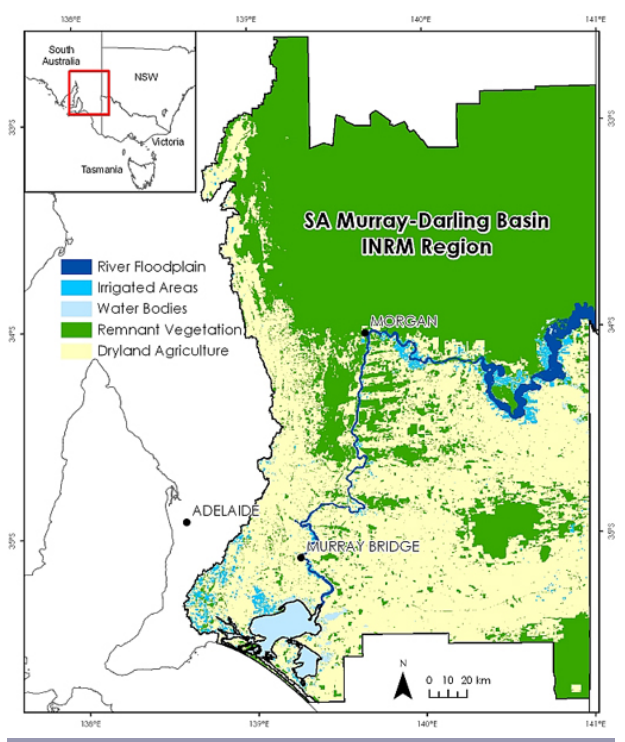
Fig. 1 . Location of the Study